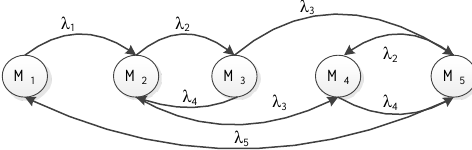
Figure 6. The reachable graph of the